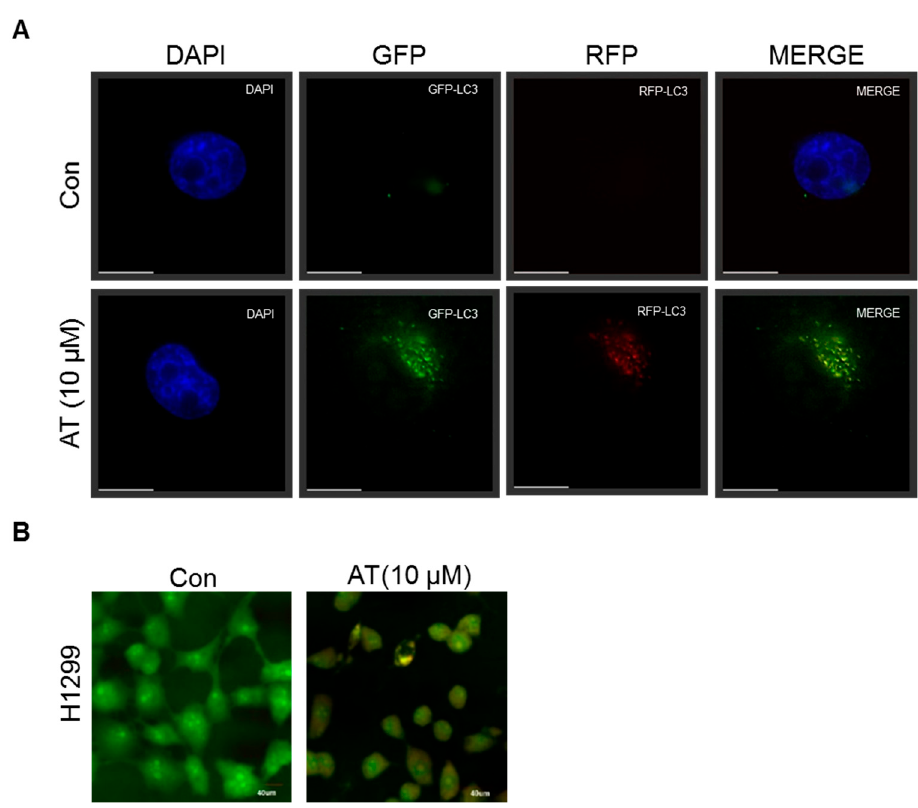
Figure 5. Atorvastatin induces impaired autophagy in H596, H460, and H1299 cells. ( A ) Effect of Atorvastatin on impaired autophagic flux in H1299 cells. H1299 cells were transfected with mRFP-GFP-LC3 constructs, exposed to Atorvastatin (10 μ M) for 48 h, and observed by confocal microscope. Bar scale = 15 μ m. ( B ) Effect of Atorvastatin on acidic autophagic vacuoles in Atorvastatin treated H1299 cells. H1299 cells were treated with Atorvastatin for 48 h and were stained with acridine orange (AO). Bar scale = 40 μ m .